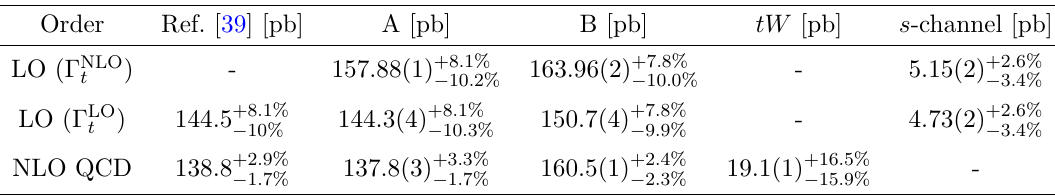
Table 5 . Comparison between the two approximations (A and B) described in the text, at the cross section level. The LO tW process contributes to the NLO QCD in the approximation B. At NLO we use (cid:0) NLO t